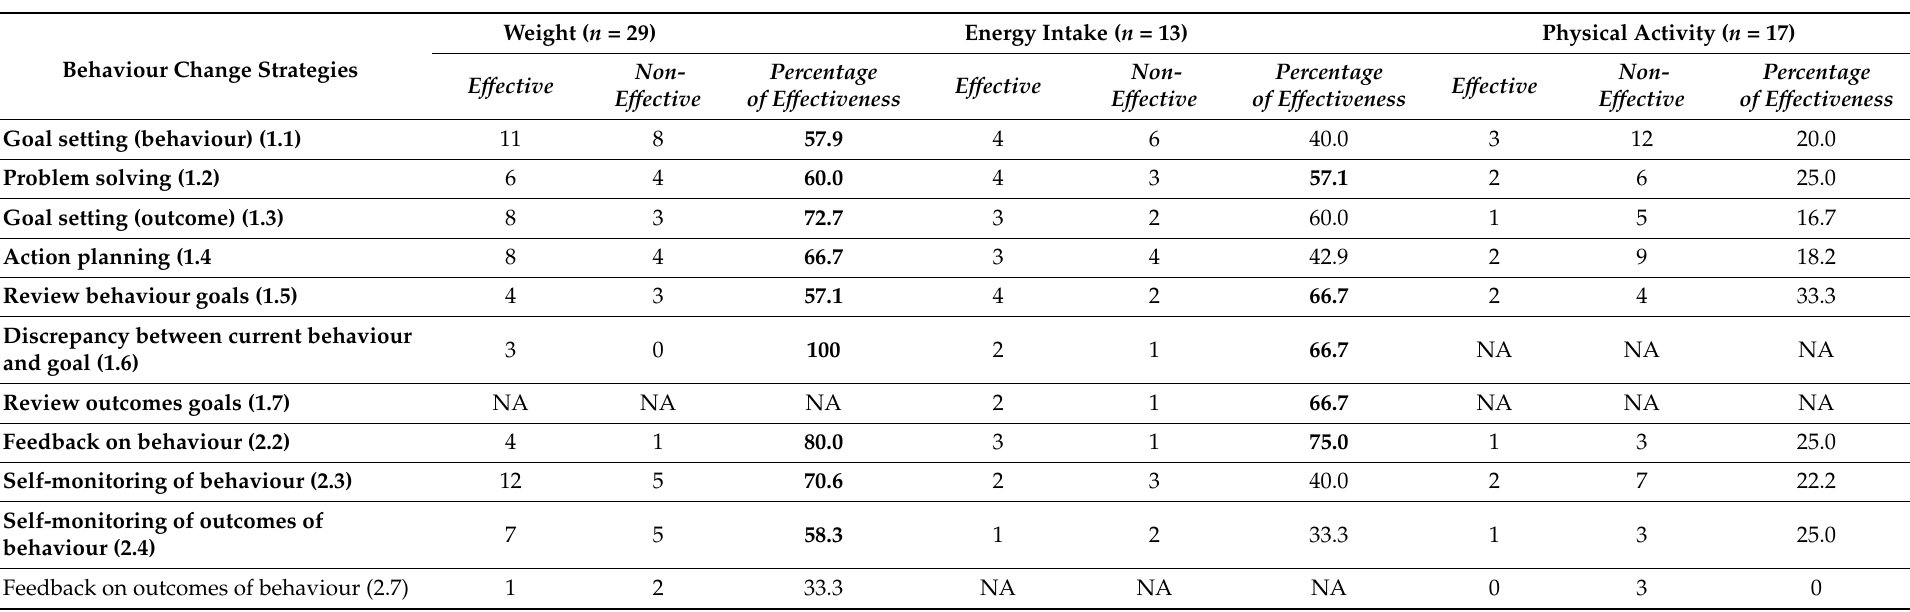
Table 2. Percentage of behaviour change techniques used in effective and non-effective interventions for weight, energy intake and physical